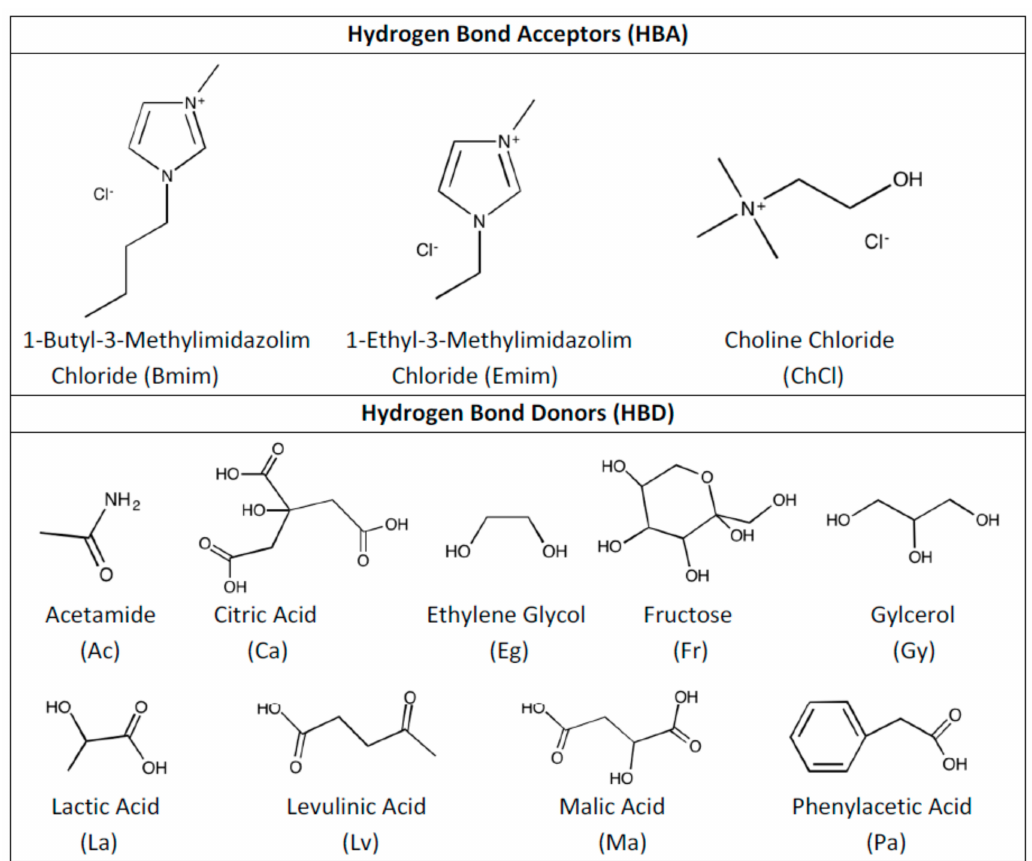
Figure 1. Molecular structures of hydrogen bond acceptor (HBA) and hydrogen bond donor (HBD) that are used in this